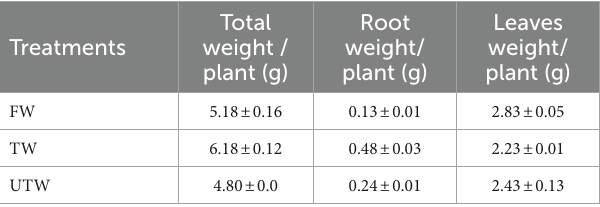
TABLE 3 Effect of irrigation quality on zucchini production.